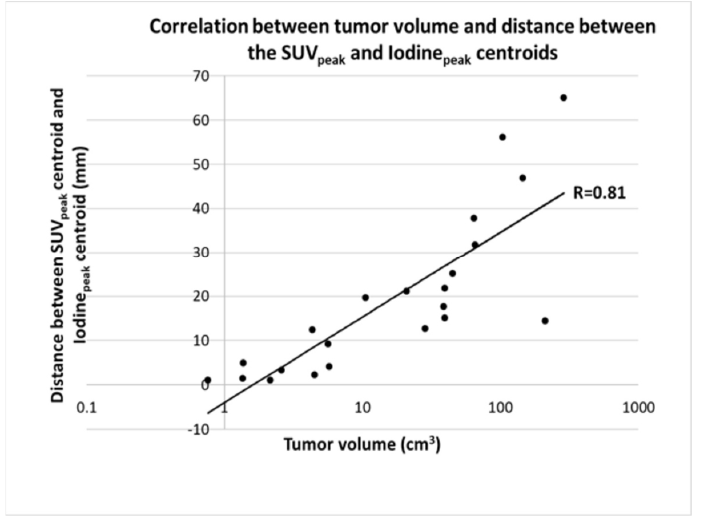
Figure 5. Scatter plot showing the correlation between the tumor volume (on a log scale) and the distance between the SUV peak centroid and the Iodine peak centroid. There was a significant positive correlation ( p < 0.0001) between both, indicating that with an increase in tumor volume, there is an increase in the distance between the high-FGD-uptake area, and the high-iodine-uptake area.